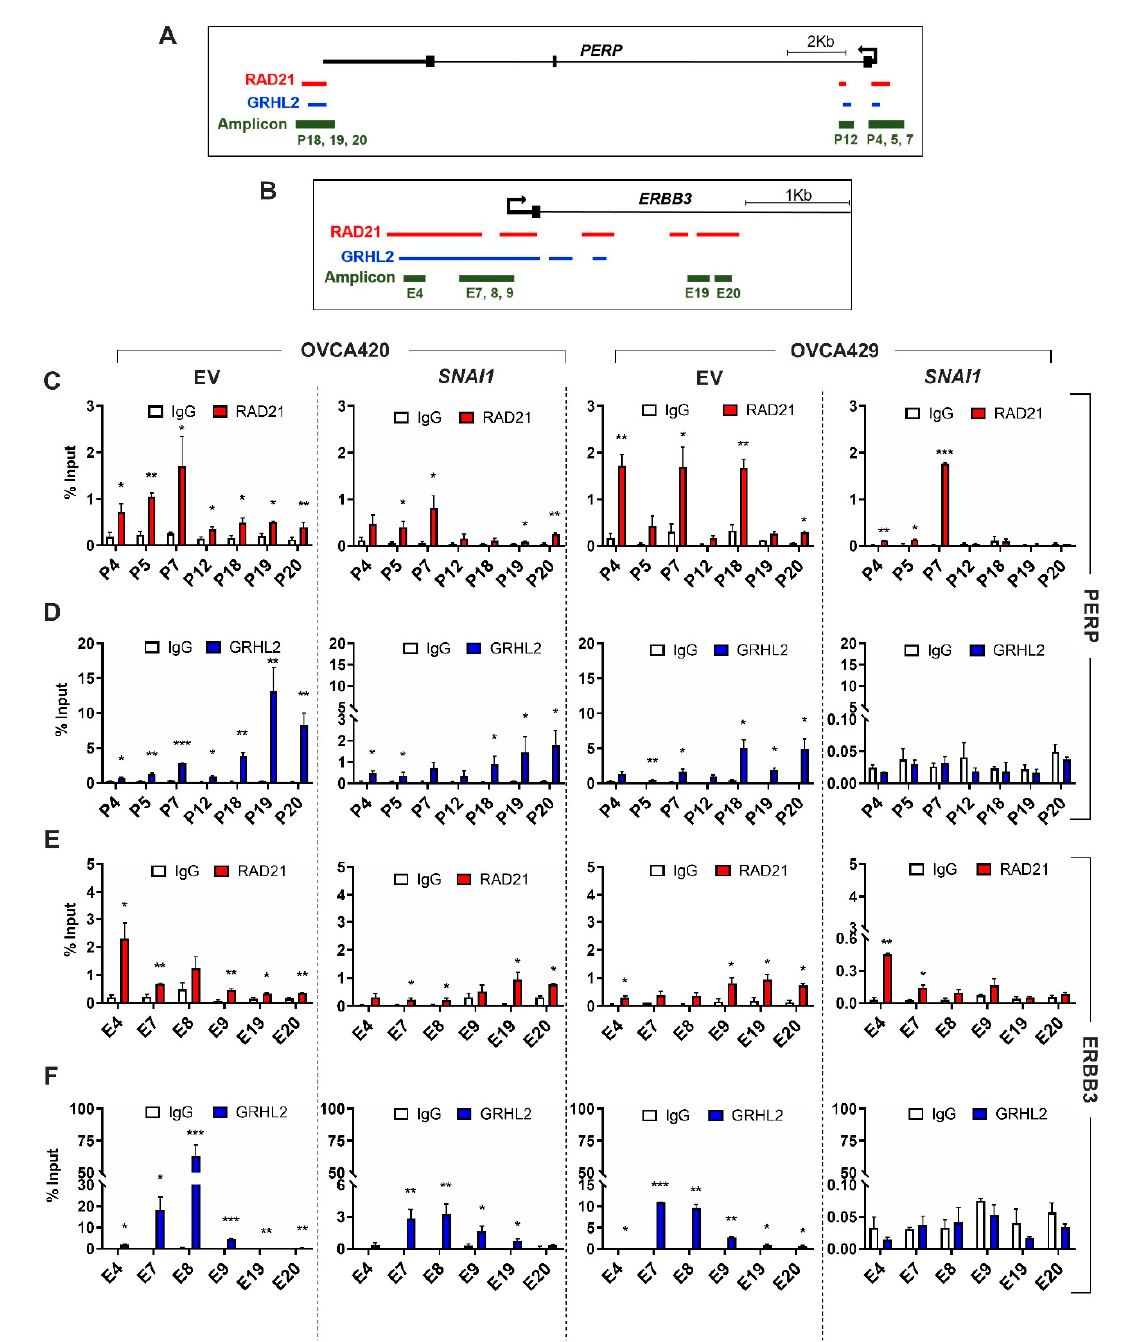
Figure 3. Enrichment of RAD21 and GRHL2 among regulatory regions on ERBB3 and PERP loci significantly varies along the EMT spectrum. ( A , B ) Schematic representation of human PERP ( A ) on chromosome 6q23.3 and ERBB3 ( B ) on chromosome 12q13.2, with pointed arrows indicating the transcription start site. RAD21 (red), GRHL2 (blue) binding sites, and the regions amplified (amplicons, green) after chromatin immunoprecipitation (ChIP) were depicted. ChIP-seq-binding regions (obtained from ReMap 2018 [36]). ( C – F ) ChIP assay was performed for SNAI1 -overexpressing OVCA420 and OVCA429 cells and respective control cells (EV) using antibodies specific for RAD21 (red, C , E ); GRHL2 (blue, D , F ); or IgG (white, C – F ) on PERP ( C , D ) or ERBB3 ( E , F ) gene loci. Signals were normalized to input DNA (1%) and plotted as enrichments relative to their respective IgG control. Results for at least two biological replicates were shown ± SEM. Unpaired t -tests were performed to compute statistical significances; * p < 0.05, ** p < 0.01, and *** p < 0.001.